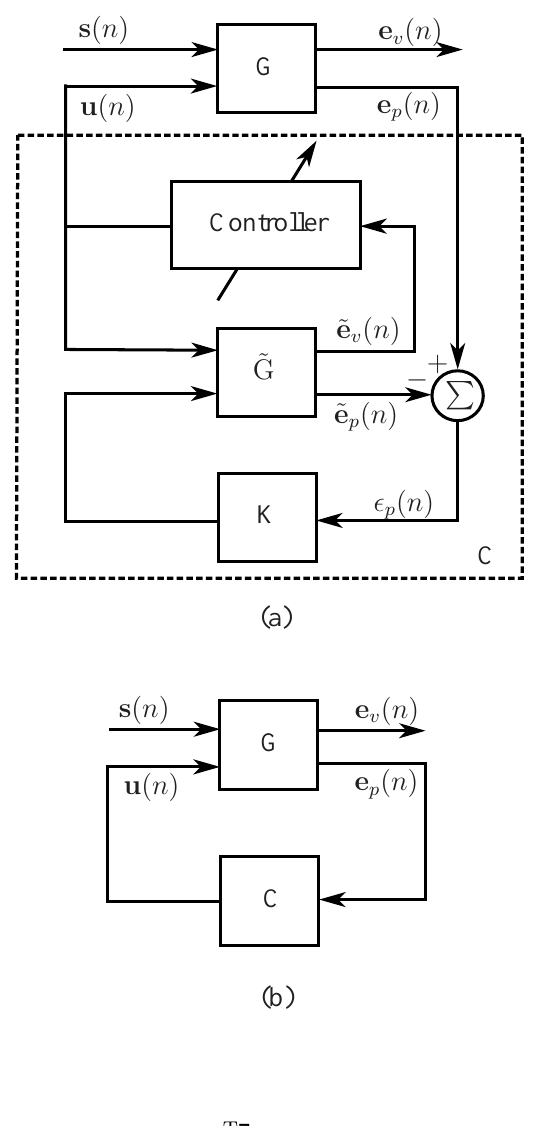
Figure 9. Block diagram of (a) implementation of the Kalman filtering virtual sensing method and (b) the generalised control configuration with two sets of inputs and two sets of outputs [53]. Algorithms 2008 , 1